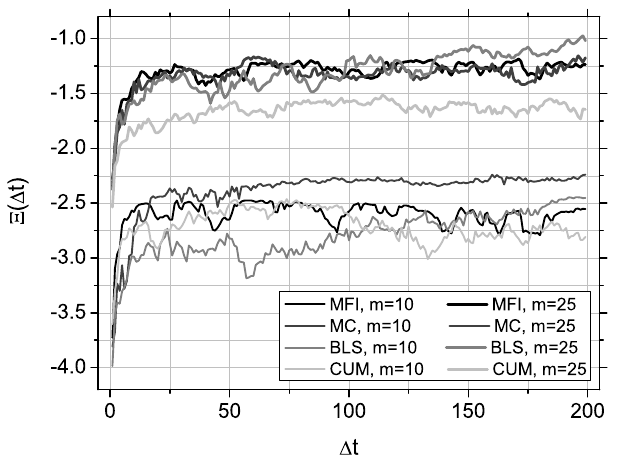
Fig. 9. 4(1t) patterns for the embedding dimensions m equal to 10 and 25 (see text for